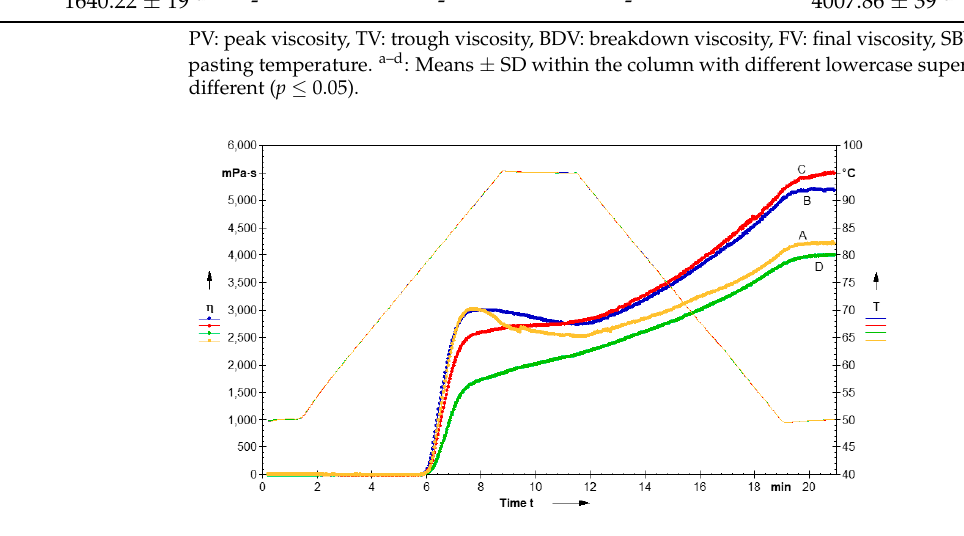
Figure 3. Pasting profile of native and modified cross-linked lotus seed starches. ( A ) Native LS, ( B ) CL-LS-1, ( C ) CL-LS-3, ( D )